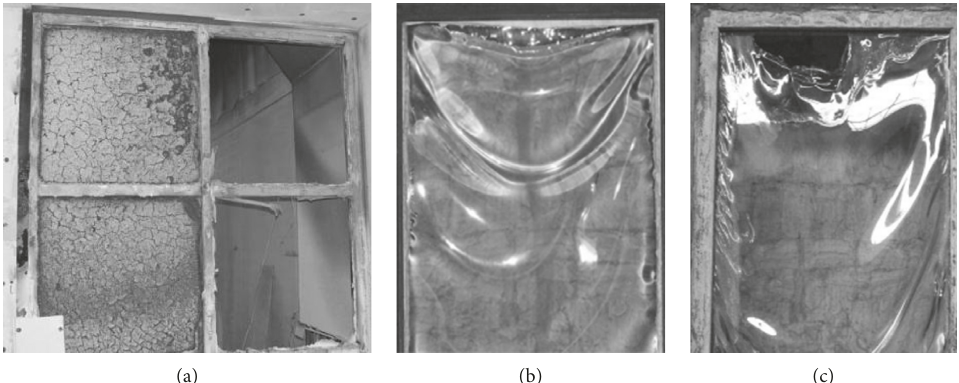
Figure 10: Failure mechanism in FR glass systems, as observed by (a) Manzello et al. [71], with evidence of fallout, and (b)-(c) by Yang et al. [40] on FR monolithic panes.